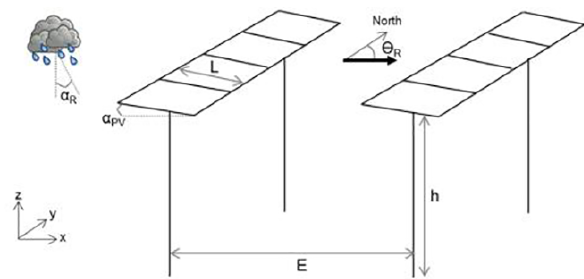
Figure 3. Scheme of the simulated scene, indicating the key param- eters of the AVrain model that describes rain redistribution by the solar panels on agrivoltaic plots.